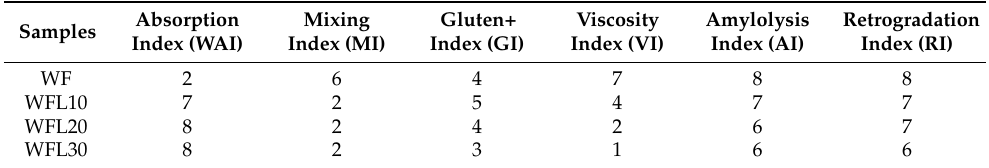
Table 10. Profiler Mixolab indices expressed on a scale from 0–9 (Mixolab